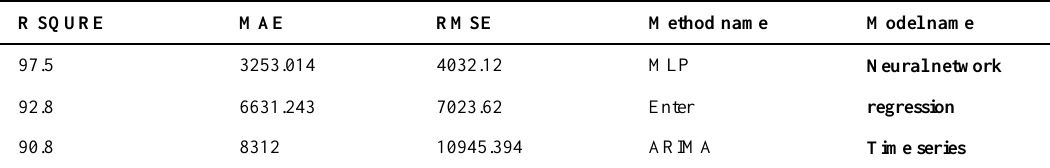
Table 16. The comparison between techniques using the factors in previous